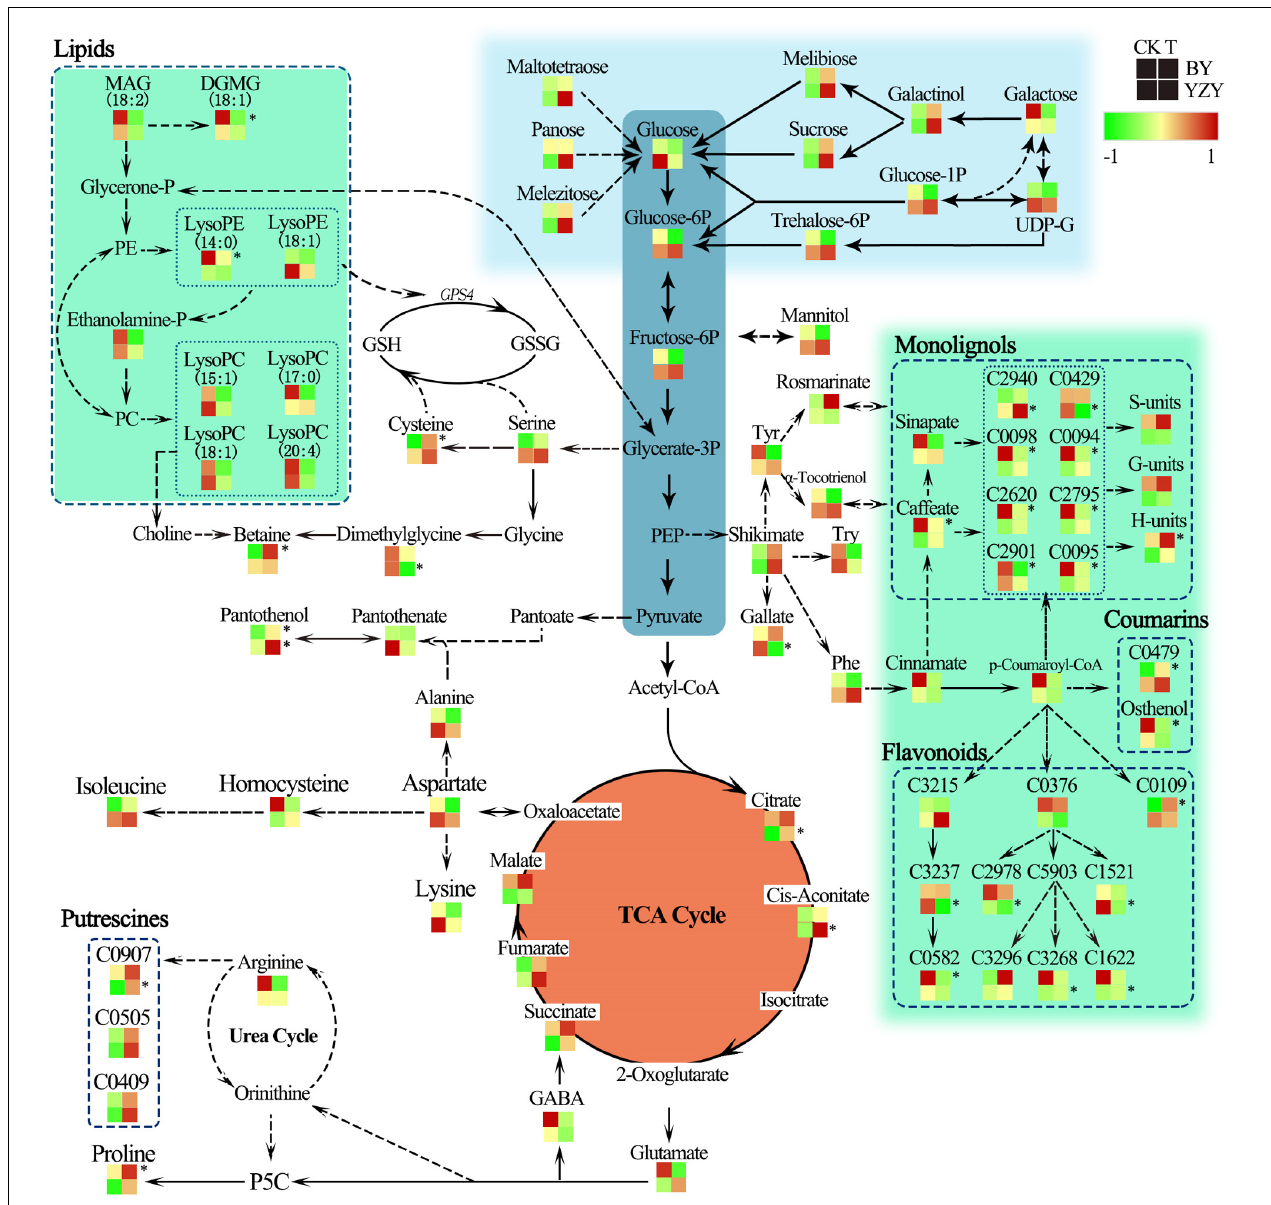
FIGURE 9 | Change in metabolites of the metabolic pathways in roots of oat seedlings after 12 days saline-alkali stress treatment. Proposed metabolic network changes in oat seedlings subjected to saline-alkali stress, as obtained using orthogonal partial least squares discriminant analysis. H -units, p -coumaryl alcohol; S -units, sinapyl alcohol; G -units, coniferyl alcohol; GABA, γ -aminobutyric acid; GPS4, phospholipid-hydroperoxide glutathione peroxidase; GSH, glutathione; GSSG, glutathione disulfide; LysoPE, 1-octadecanoyl-sn-glycero-3-phosphoethanolamine; MAG, monoacylglycerol; P5C, δ -pyrroline-5-carboxylate; PE, phosphatidylethanolamine; Phe, phenylalanine; PEP, phosphoenolpyruvate trisodium salt; SAH, S -adenosyl- L -homocysteine; Try, tryptophan; Tyr, tyrosine; C0094, methyl p -coumarate; C0095, methyl ferulate; C0098, trans -4-hydroxycinnamic acid methyl ester; C0109, 3- O -acetyl pinobanksin; C0376, naringenin; C0429, 3,4,5-trimethoxycinnamic acid; C0479, 8-methoxypsoralen (xanthotoxin); C0582, glabridin; C0907, N -feruloyl putrescine; C1521, dihydroquercetin (taxifolin); C1622, kaempferol 3- O -glucoside (astragalin); C2620, 3,4-dimethoxycinnamic acid; C2795, 4-methoxycinnamic acid; C2901, 1- O -caffeoyl quinic acid; C2940, 1- O -beta- D -glucopyranosyl sinapate; C2978, apigenin O -hexosyl- O -pentoside; C3215, isoliquiritigenin; C3237, liquiritigenin; C3268, kaempferol 3- O -galactoside (trifolin); C3296, kaempferol 3- O -rhamnoside (kaempferin); C0426, pentagalloylglucose; C5903, kaempferol. *Indicate significant ( P < 0.05).